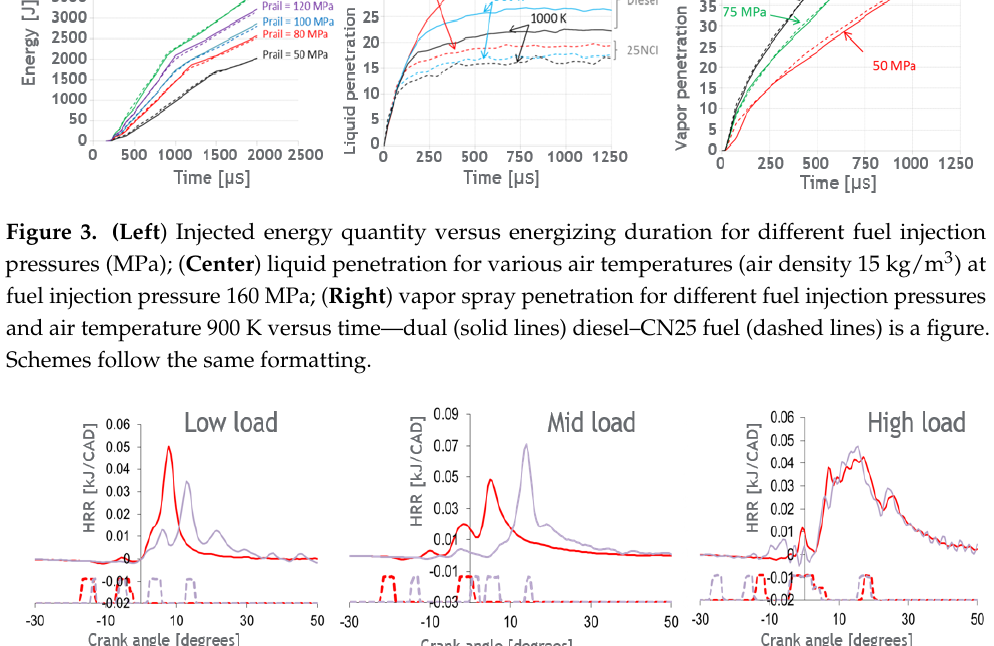
Figure 4. Average (250 cycles) heat release rate (HRR) and injection patterns with CN35 and diesel from SCE tests (4, 7.2 and 11.4 bar of IMEP and 1500 rpm).